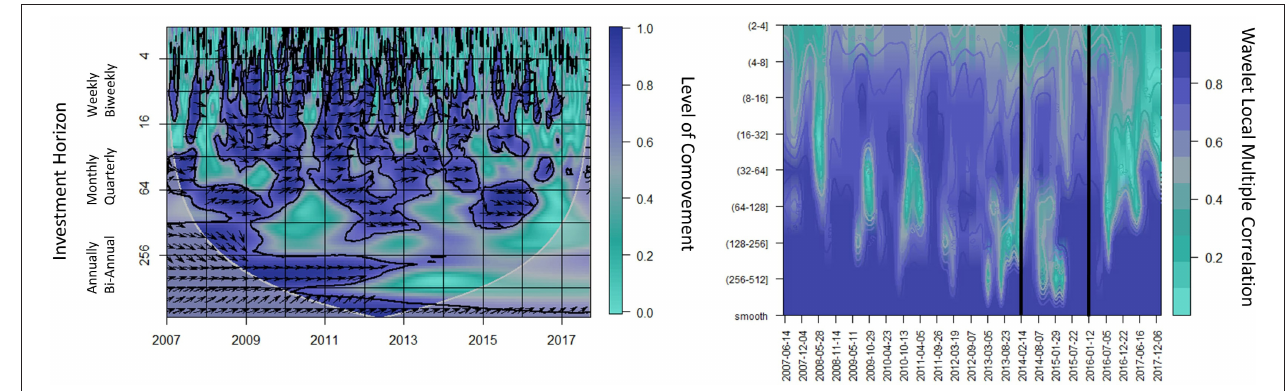
Figure A2 | Eliminating 20 % of the data we analyze the results of our analysis using the WSC of the water-energy nexus (left) and the WLMC of the water-energy nexus and the S&P500 (right) . The vertical axis shows investment horizons in days and the horizontal axis shows time in years. The darker purple the regions are the higher the statistical